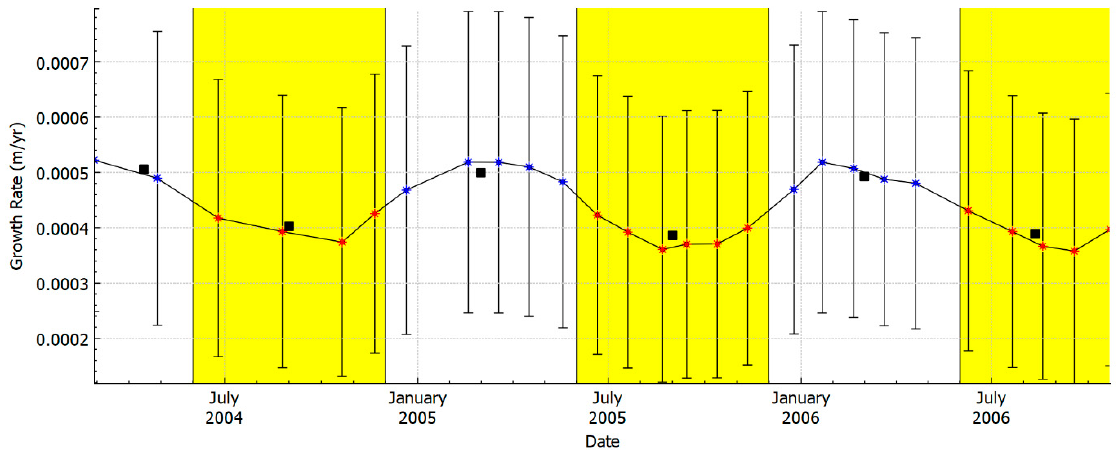
Figure 7. The user specified seasons for Inner Space Cavern, Texas. Yellow shows the season of slow growth. See supplementary material for details.